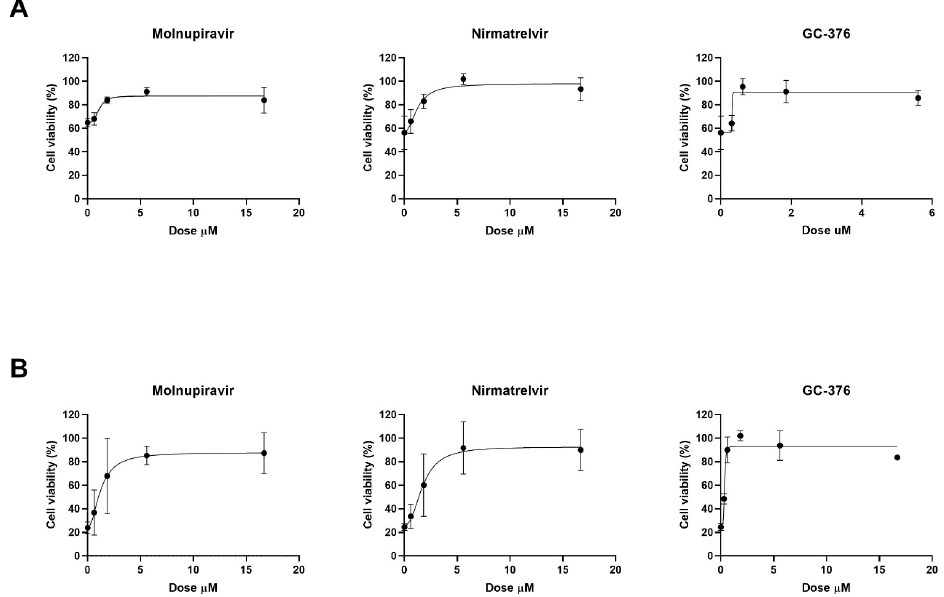
Figure 1. Four-parameter dose–response curve of molnupiravir, nirmatrelvir and GC376 dose–response. Vero E6 cells were infected with SARS-CoV-2 20A.EU1 strain and then treated with different concentrations of antivirals for ( A ) 48 and ( B ) 72 h. The viability of cells was assessed by MTT reduction assay and expressed as cell viability (%) ± SD. Data are the mean of at least 2 experiments with three technical replicates.